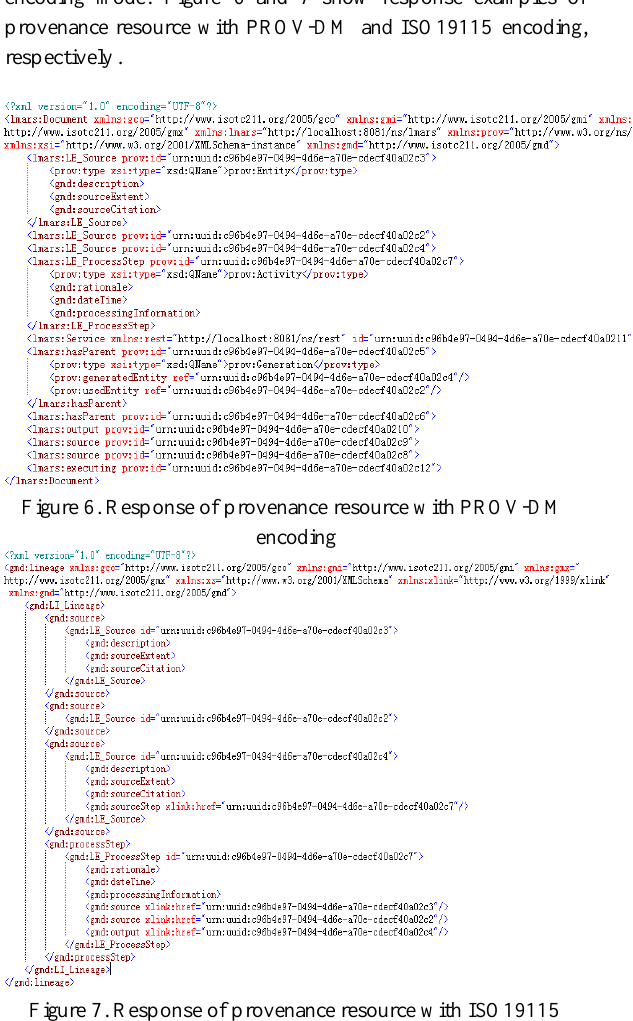
Figure 7. Response of provenance resource with ISO19115